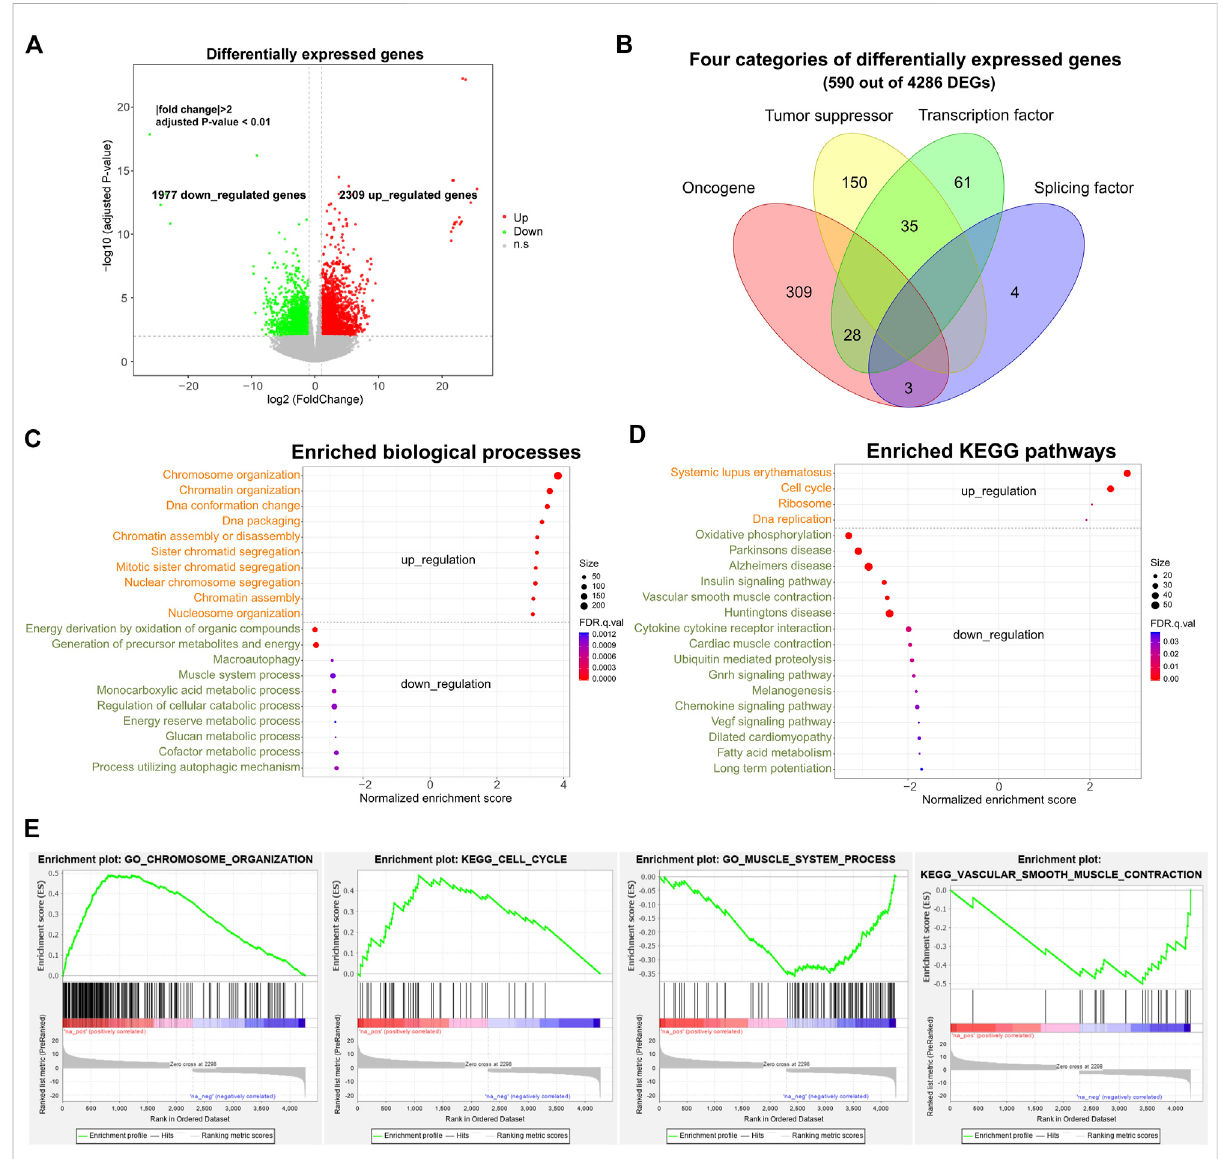
FIGURE 1 Differential expression pro fi le and corresponding gene functions of SS. (A) Volcano plot displaying differentially expressed genes (DEGs) between tenpairs ofSSand tumor-adjacenttissues. | foldchange | > 2and adjusted p -value < 0.01. (B) DifferentcategoriesofDEGs. (C) Top enriched up-regulated and down-regulated biological processes of DEGs. (D) Top enriched up-regulated and down-regulated KEGG pathways for DEGs. (E) Examples of enriched biological processes and pathways. Adjusted p -value < 0.05. DEGs: differentially expressed